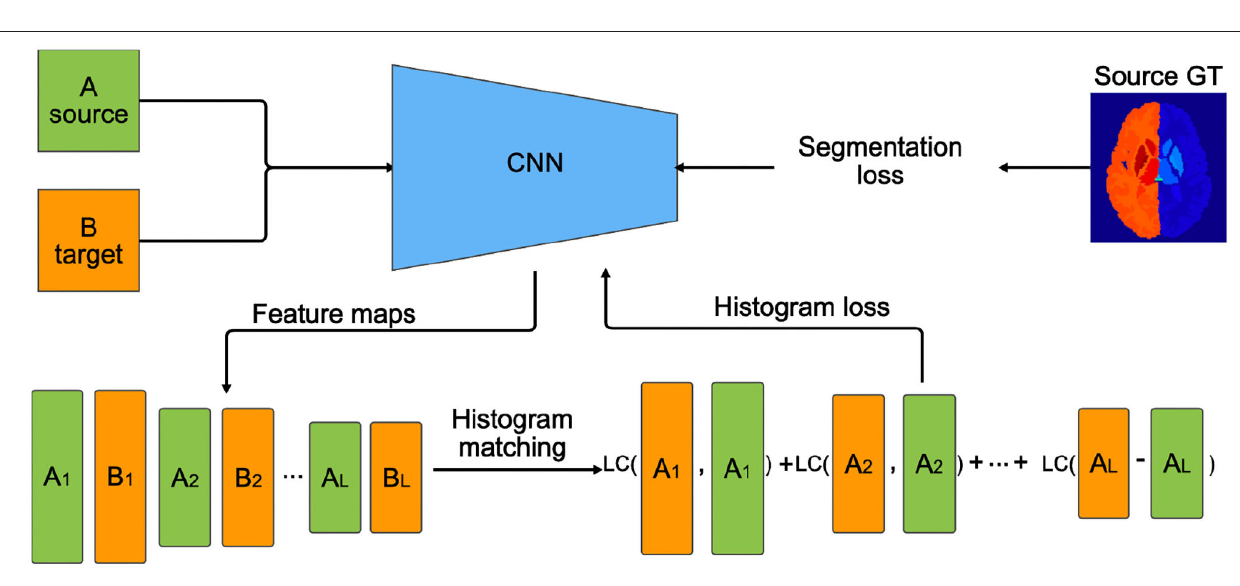
FIGURE 3 | Transductive domain adaptation training pipeline using histogram loss. A i and B i are feature maps extracted from the ith layers of the CNN. L is the number of layers on which the histogram loss is computed. Segmentation loss, in our case cross-entropy loss, is computed using the source ground truth (GT) labels. LC (LogCosh)—logarithm of hyperbolic cosine